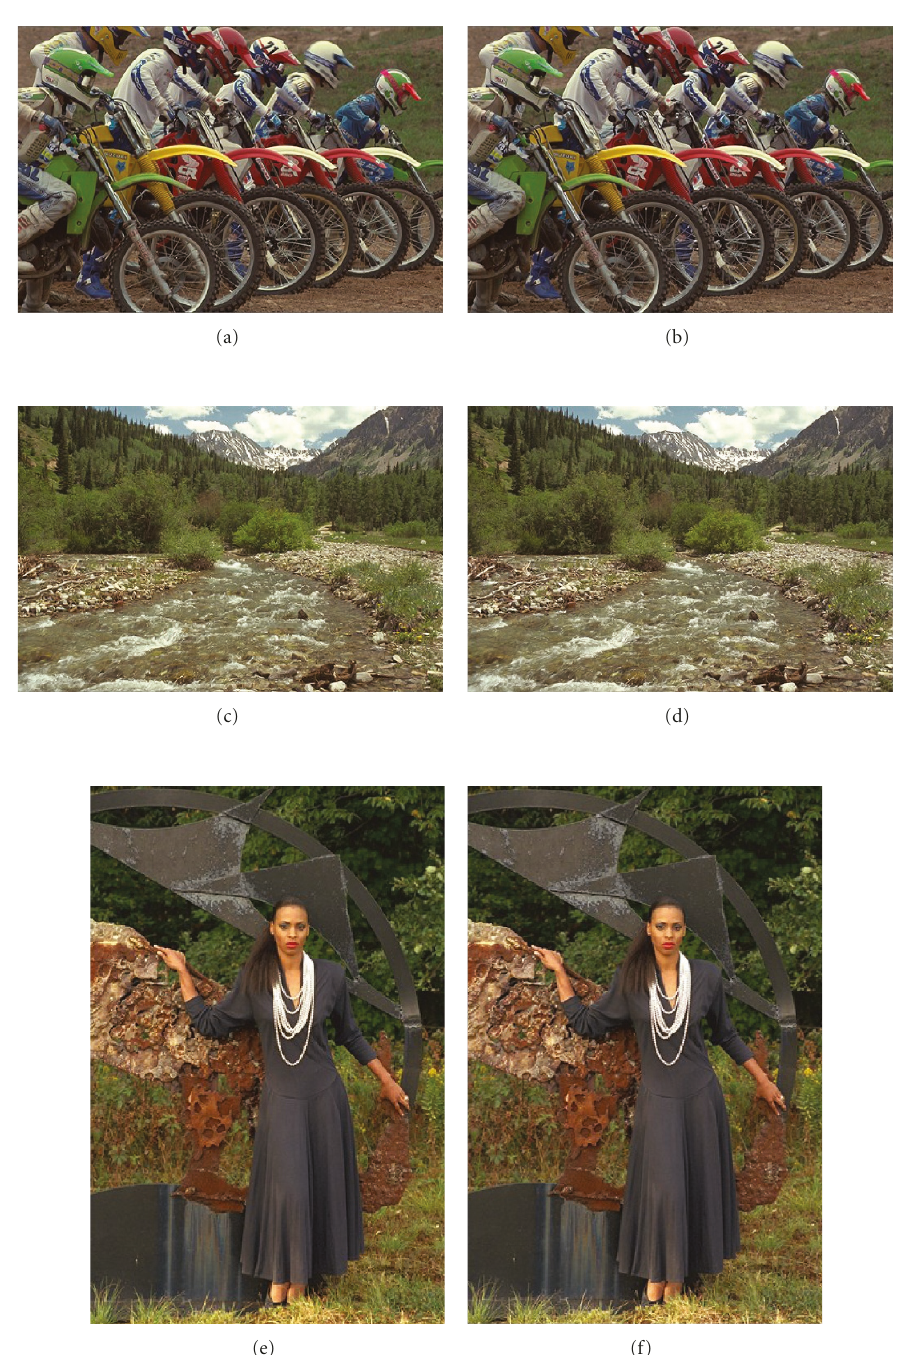
Figure 19: (a), (c), and (e) are the original images of test 5, 13, 18 and (b), (d), and (f) are their GDbDr-based FMC compressed images.